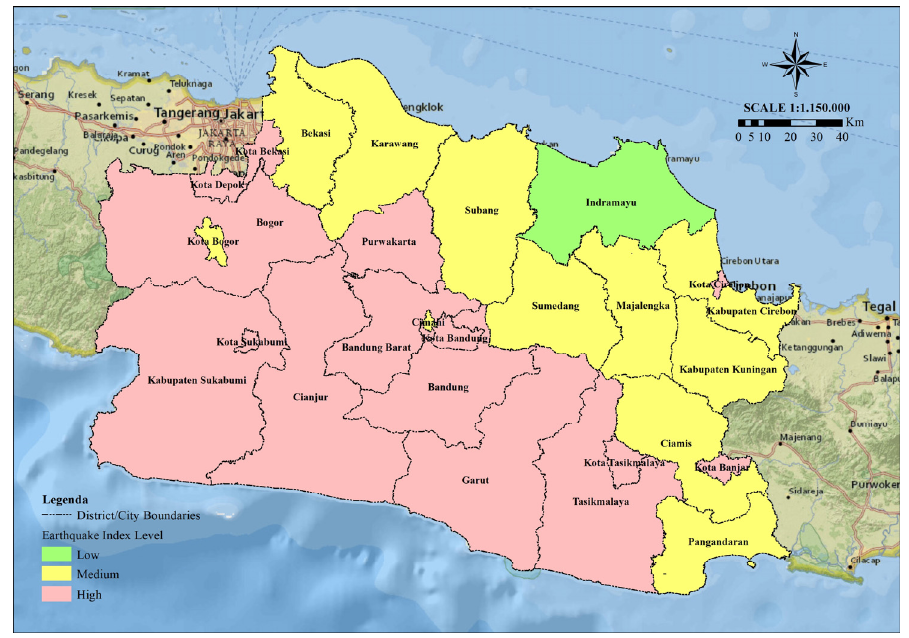
Mathematics 2023 , 11 , x FOR PEER REVIEW Figure 6. The clustering results using EDRI categories Figure 6. The clustering results using EDRI categories.